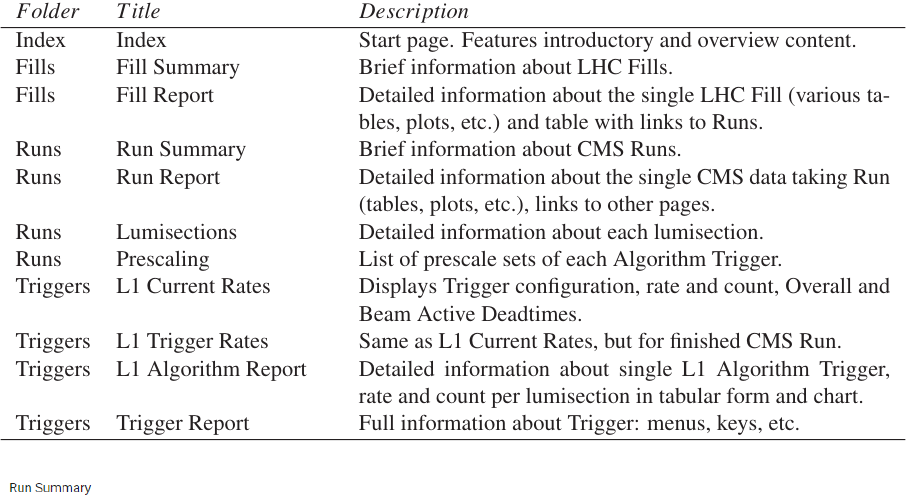
Table 1. List of OMS pages (as of paper publication time)